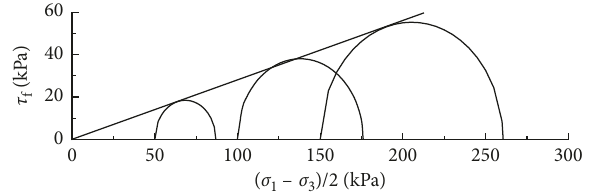
Figure 7: Relationship curves between cyclic stress ratio and failure cycles at different frequencies: (a) σ σ 3c � 150kPa.